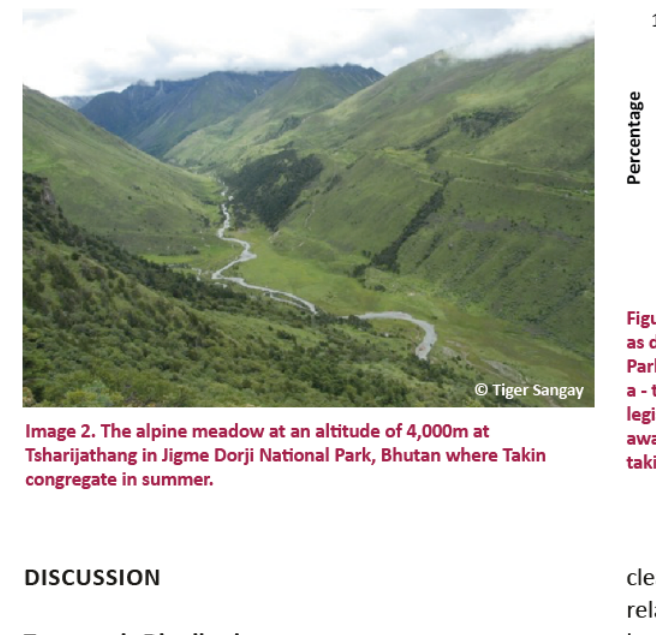
Ffigure 3. Degree off park resfidenfts’ percepfions off fthe Bhuftan Takfin, as deftermfined ffrom quesfionnafire finftervfiews fin Jfigme Dorjfi Nafional Park. a - ftakfin percefived as noft befing a fthreaft; b - aware fthaft ftakfin are legfislafively proftecfted, c - would supporft ftakfin conservafion; d - aware fthaft fthe ftakfin fis fthe nafional anfimal; e - lfiked fthe ftakfin; ff - fthe ftakfin warranfts befter